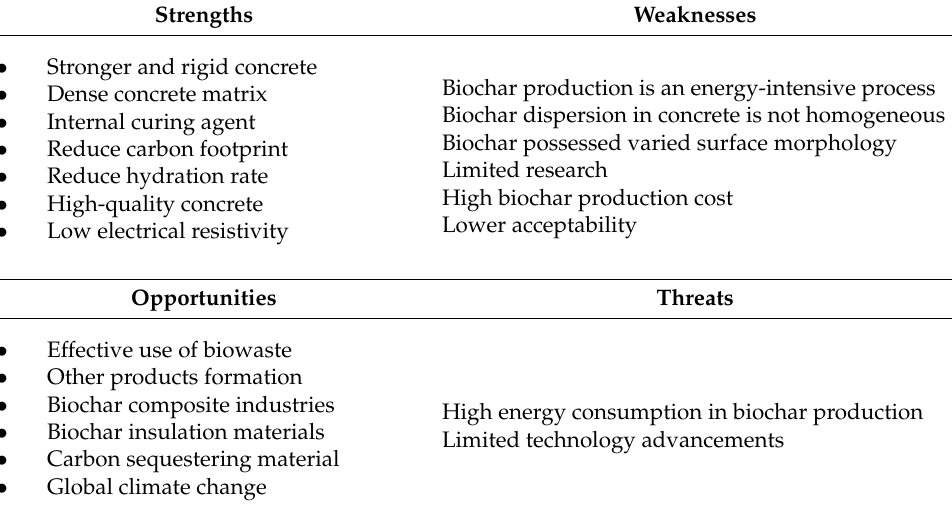
Table 2. SWOT analysis of biochar-based